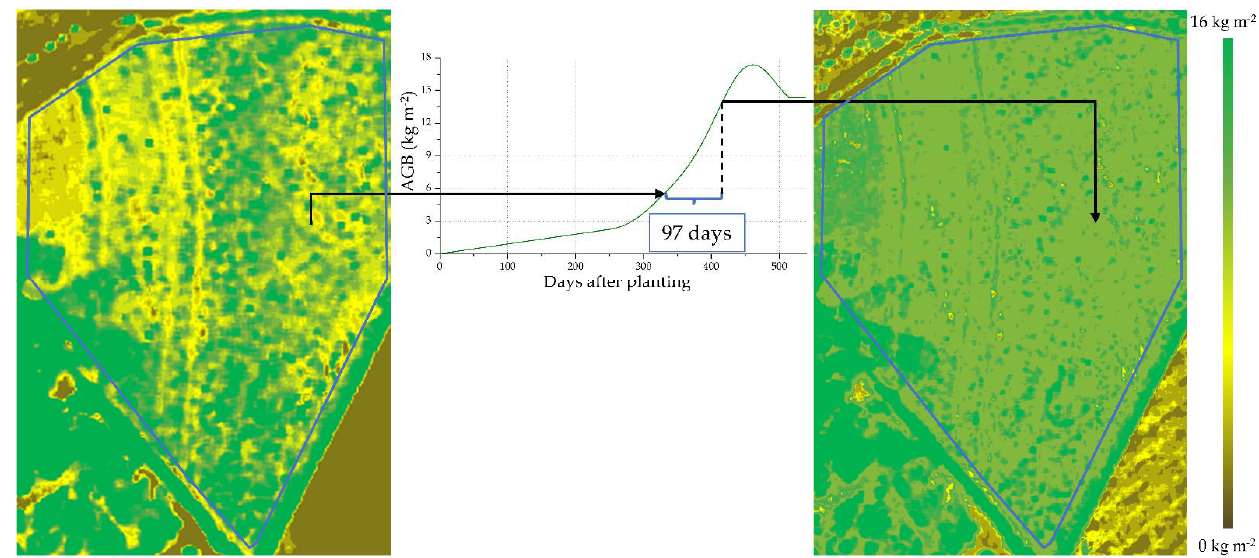
Figure 21. Representation of how the predicted AGB map of area 2 ( right side map) is obtained from the corresponding estimated AGB map of 9 April 2020 ( left side map) by carrying out a pixel-by-pixel process based on 𝑎𝑐(𝑑,1) . The blue line delimits area 2.